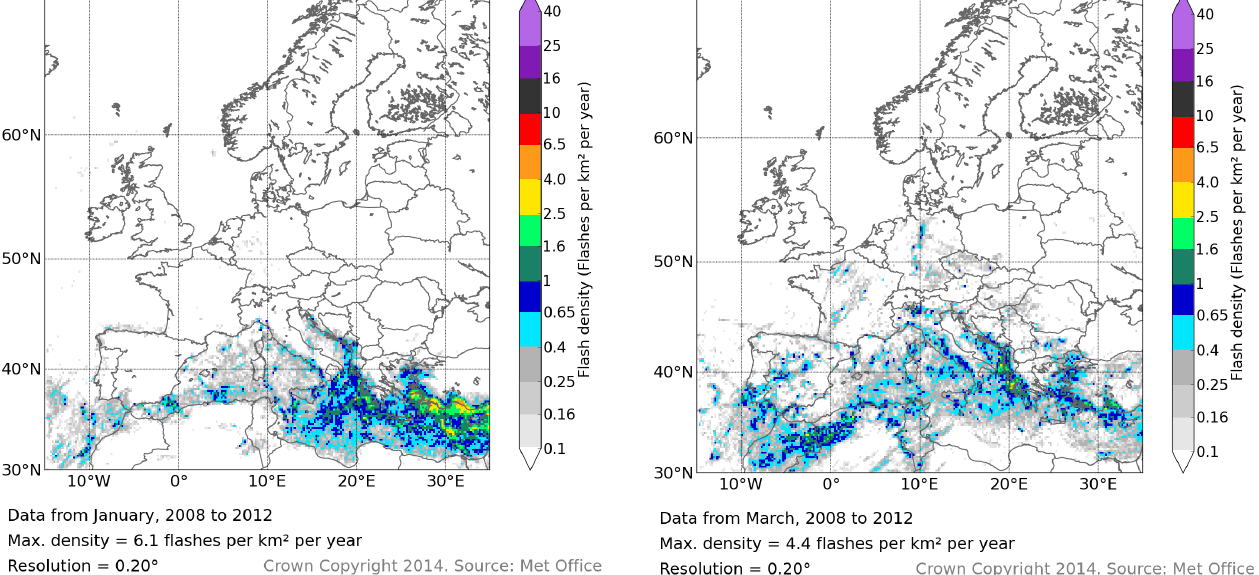
Fig. 7. Detected lightning flash density for